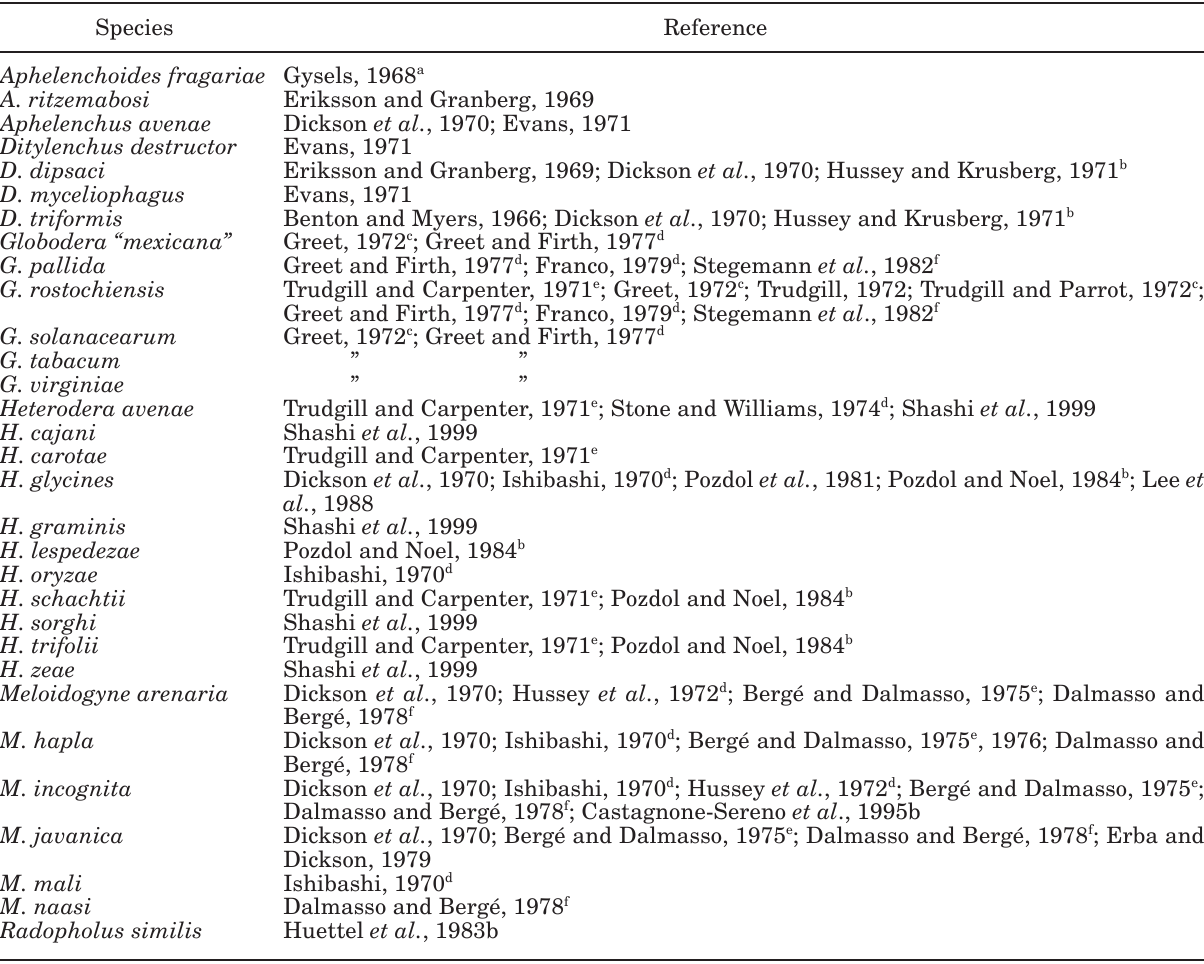
Table 1. Plant-parasitic nematode species characterized on the basis of proteins, using one-dimensional native gel electrophoresis. Species